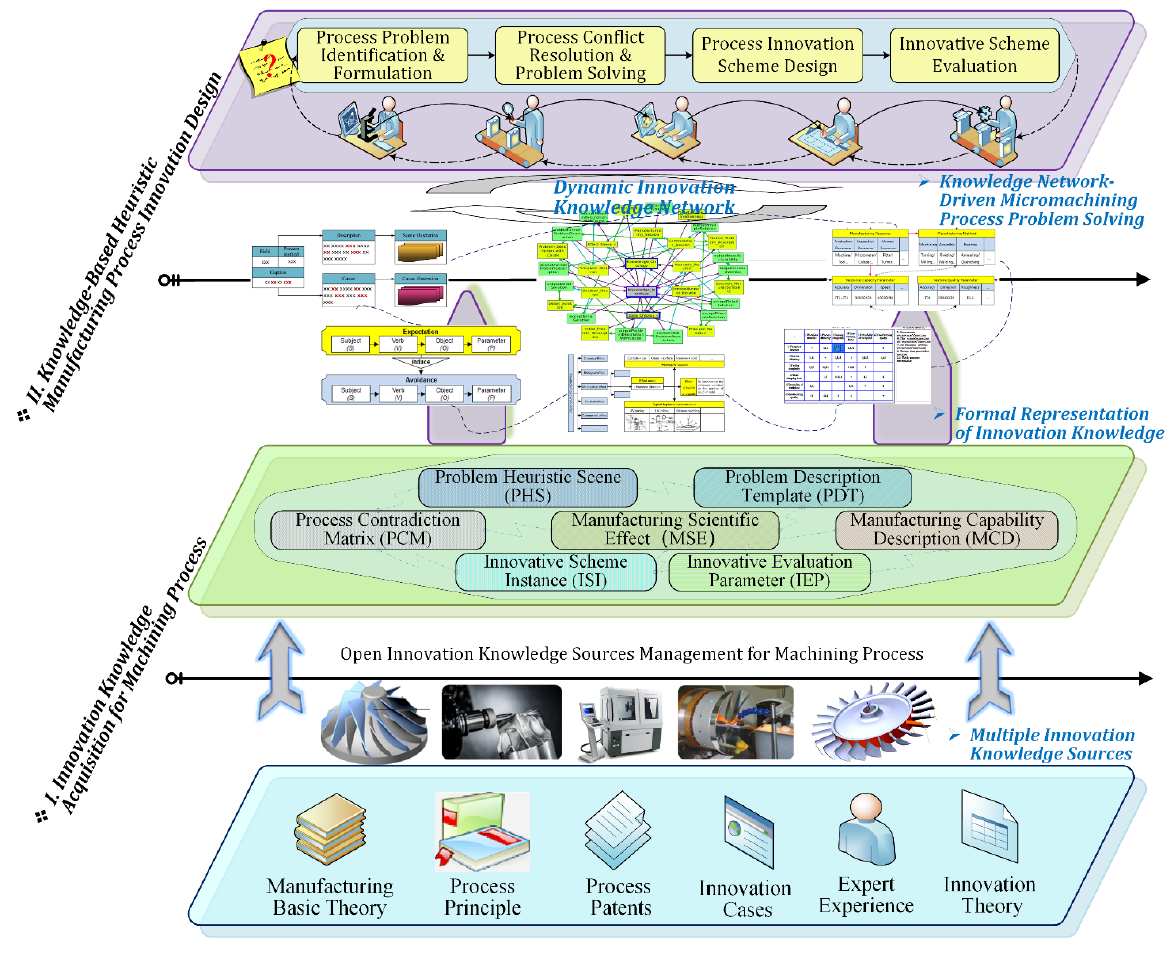
Figure 1. A holistic framework of knowledge-based heuristic manufacturing process innovation.